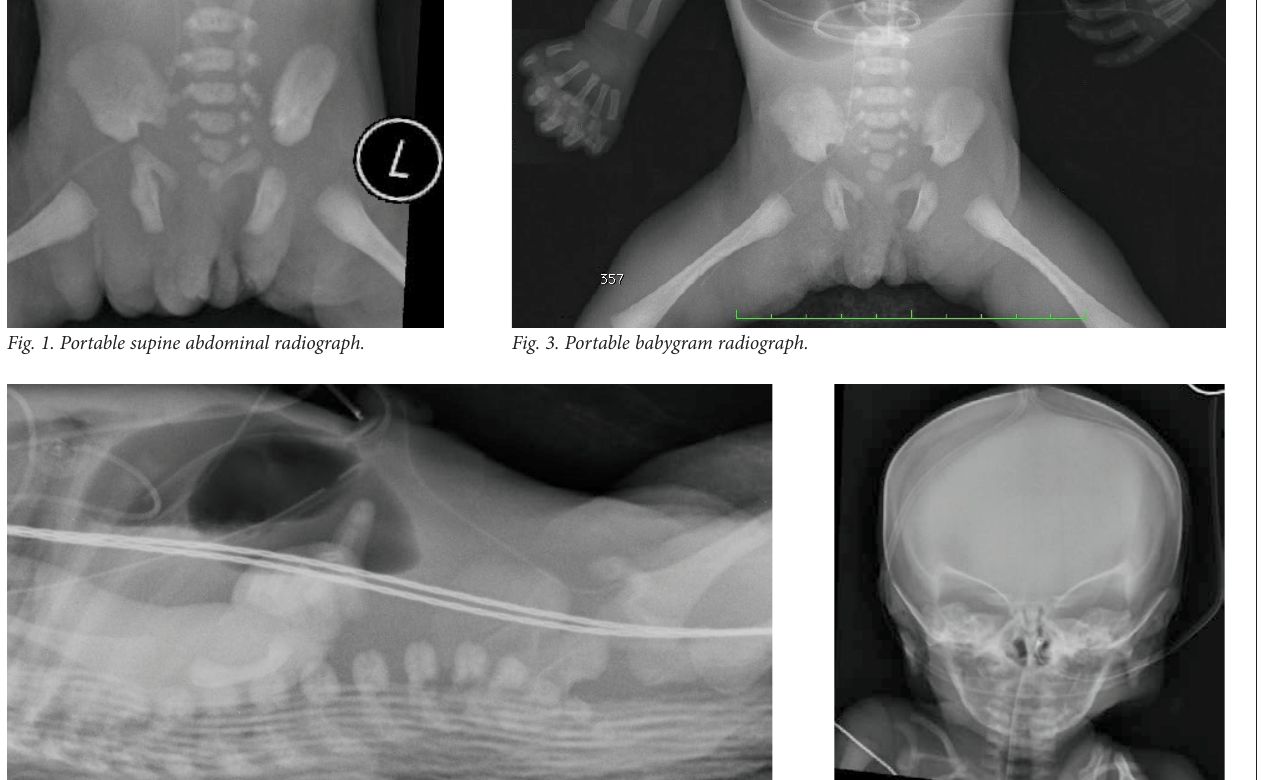
Fig. 4. Portable occipito-frontal